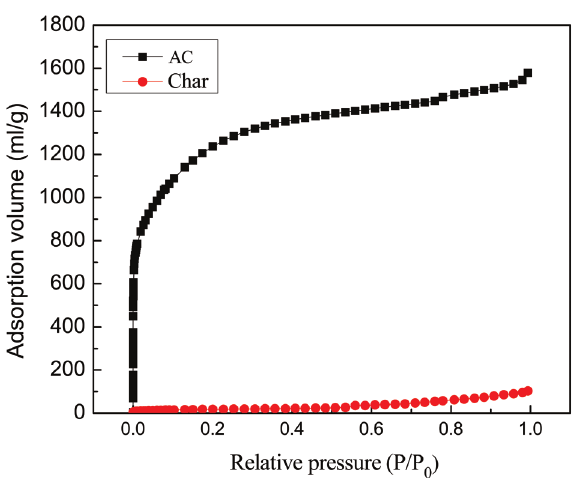
Figure 1: Nitrogen adsorption isotherm pore size distribution of the AC and char.